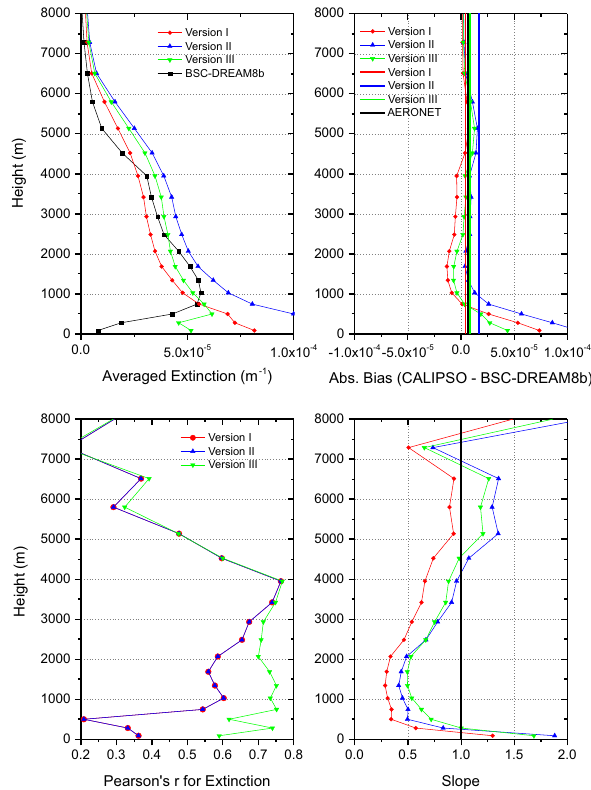
Fig. 9. Comparison between Level 3 extinction CALIPSO prod- uct and BSC-DREAM8b model outputs for the three versions of CALIPSO climatological product. Upper: averaged extinction pro- file over the domain (left) and absolute biases (right). Lower: Pear- son’s correlation coefficient profile for the domain (left) and regres- sion slopes